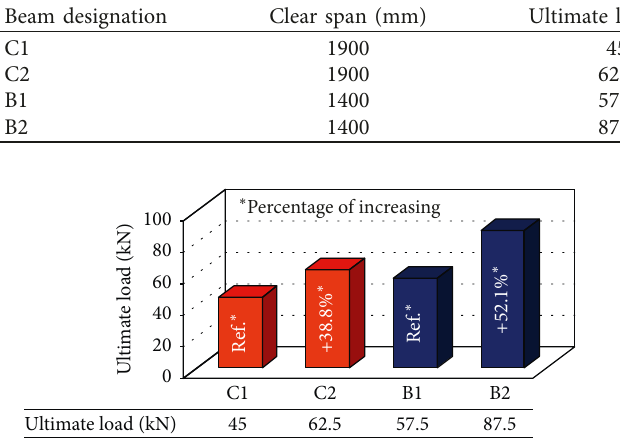
Figure 9: Effect of using CFRP on ultimate load with various clear spans.